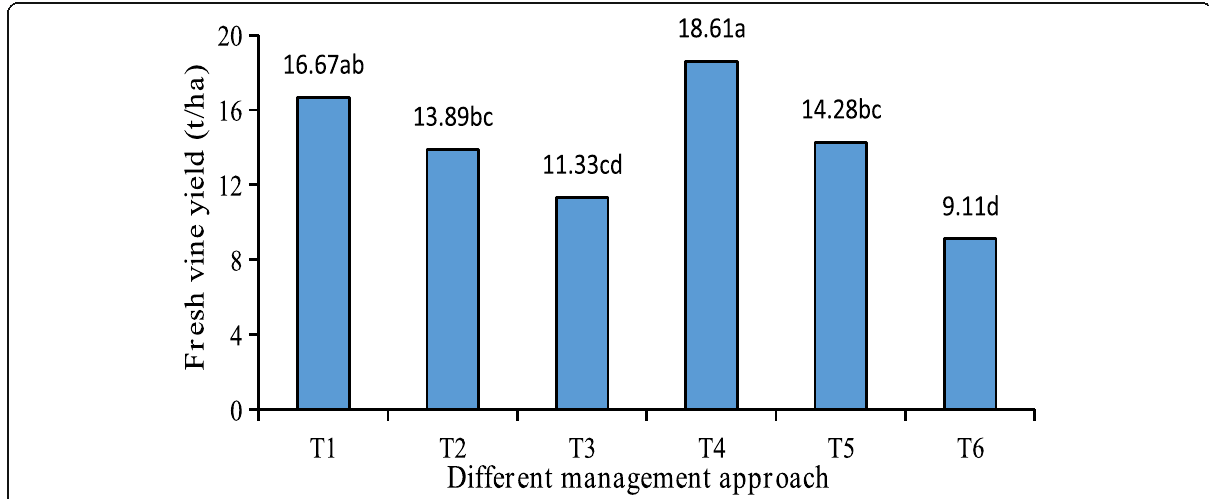
Fig. 2 Effect of different treatments on fresh vine yield of betel leaf. T 1 = sanitation + spinosad + abamectin, T 2 = sanitation + azadirachtin + antario, T 3 = ,anitation + abamectin + fytoclean, T 4 = sanitation + fizimite + antario, T 5 = farmers practice, and T6 = untreated control (water